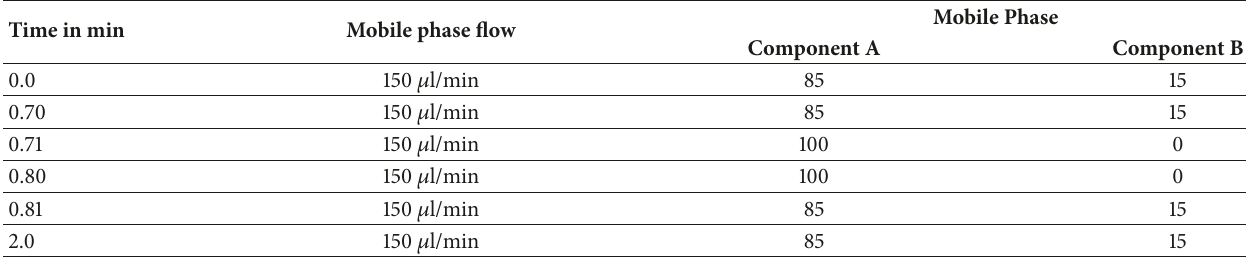
Table 1: Representing gradient scheme of mobile